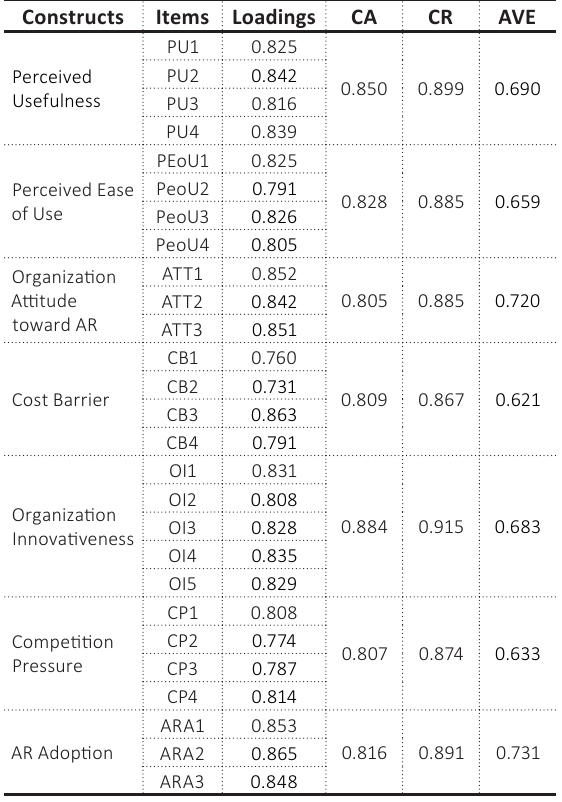
Table 1. Outer loadings, Cronbach’s